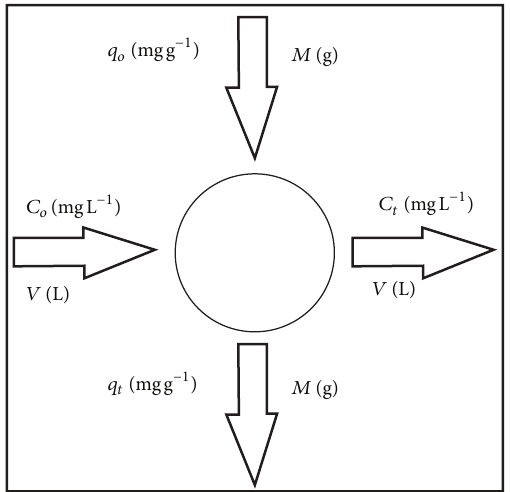
Figure 7: Design of single-stage batch system for dye biosorption.